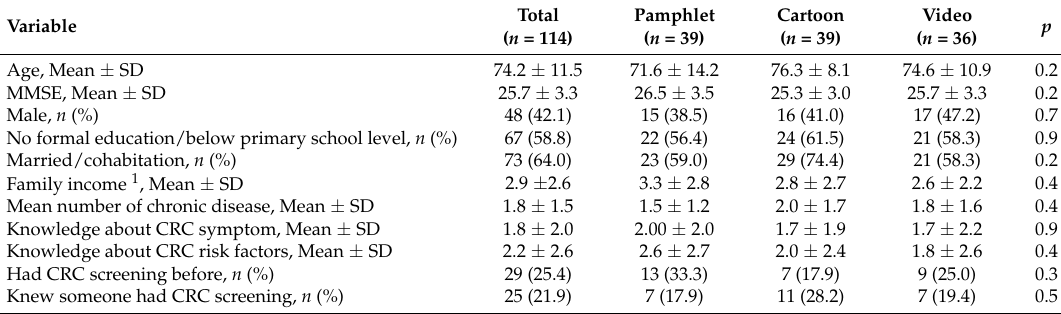
Table 2. Characteristics of study participants.